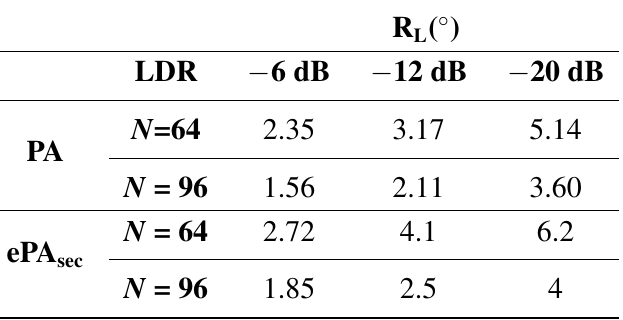
Table 2. Lateral resolution obtained with PA and ePA